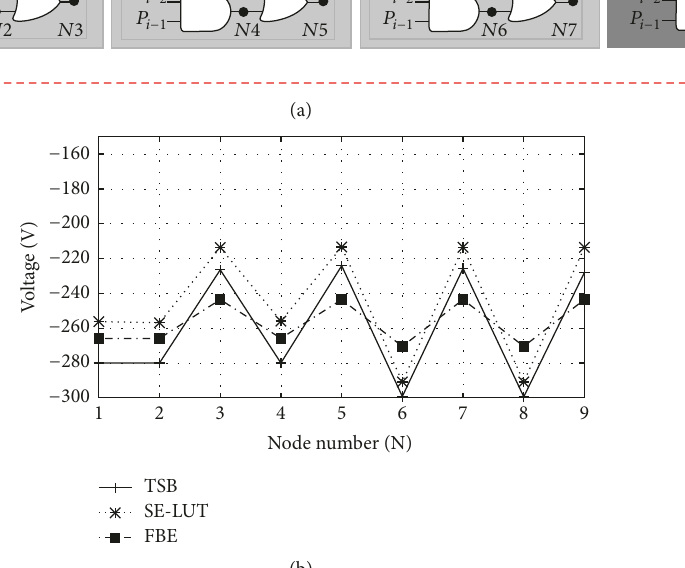
Figure 19: (a) A schematic of sparse tree area highlighted in Figure 16. Voltage level at each selected node (N1 to N9) of the sparse